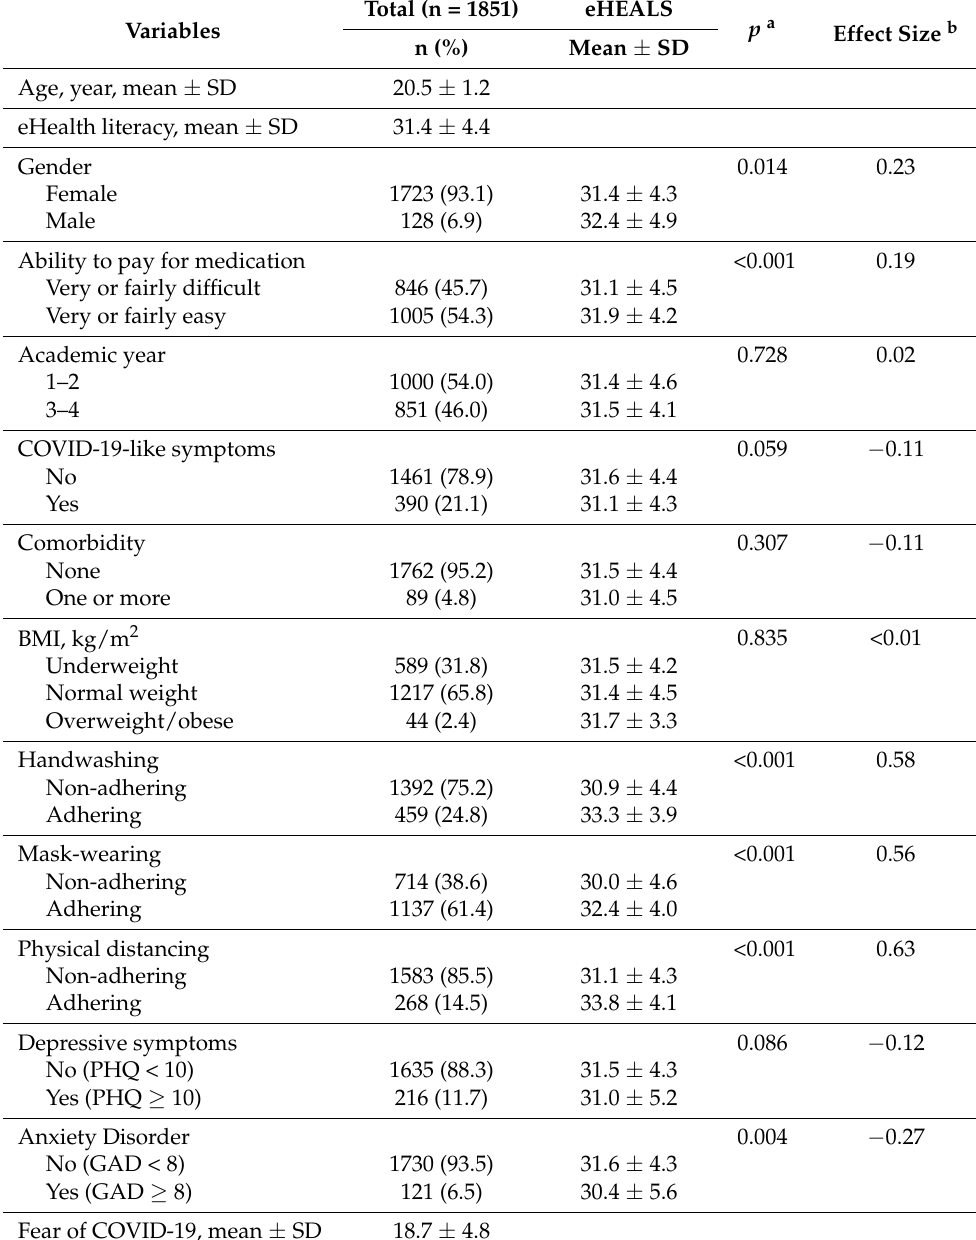
Table 1. Characteristics of nursing students (n =